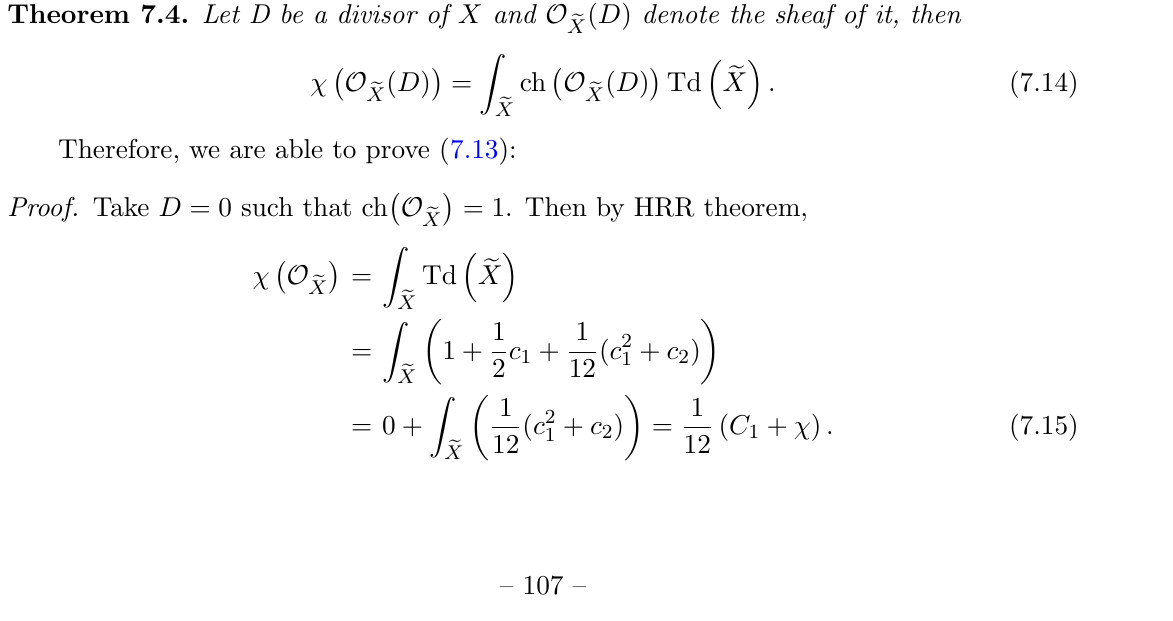
Figure 4. The green points correspond to zeroth-grade points) of triangles are in